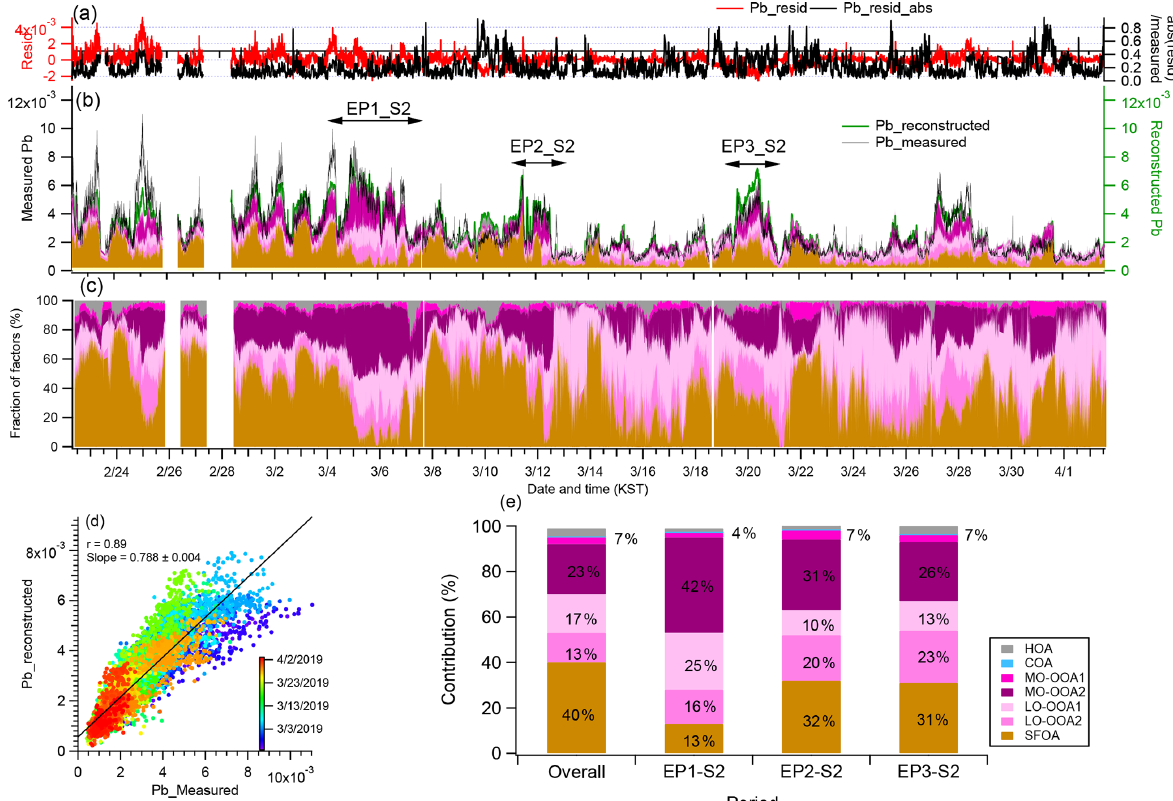
Figure 8. Diagnostic plots of the Pb decomposition results. (a) Time series of the ratio of the residual to the measured Pb concentration and variations in the absolute fitting residuals; (b) time series of the measured Pb and the stacked contributions of all fitted sources of the OA; (c) time series of the contributions of all fitted sources of the OA; (d) scatter plot and linear fit between the measured and reconstructed Pb concentrations where a good agreement was observed between the measured and reconstructed Pb concentrations, with a linear regression slope of 0.79 and r value of 0.89; (e) the average contribution of the different factors to Pb during overall, EP1-S1, EP2-S2, and EP3-S2 periods. Numbers indicate the fraction of each source and HOA, COA, and MO-OOA1 fractions are summed since their fractions were very